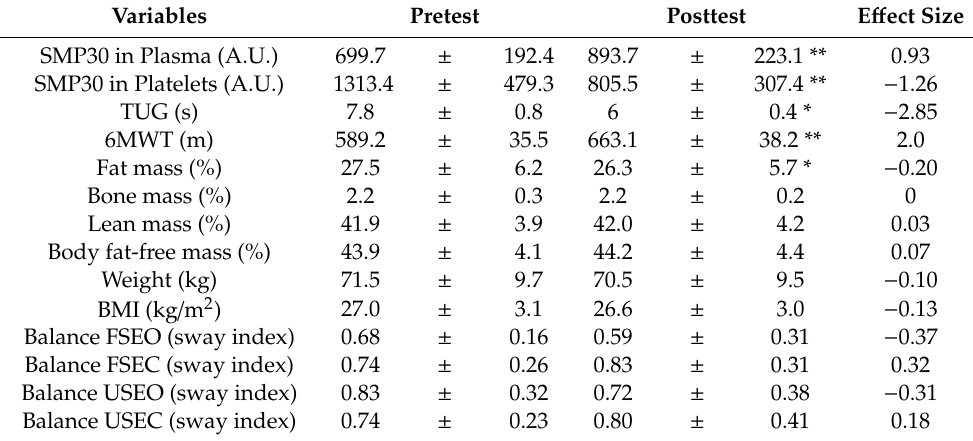
Table 2. SMP30, physical fitness and body composition before (pre-test) and after (post-test) the Whole Body Vibration training program. Mean ± standard deviation. Variables Pretest Posttest E ff ect Size SMP30 in Plasma (A.U.) SMP30 in Platelets